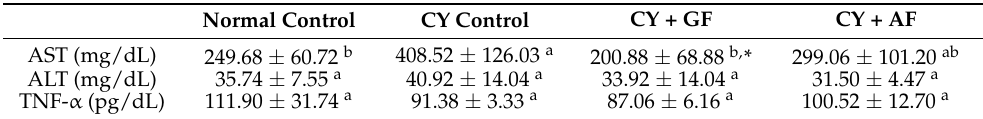
Table 4. Plasma cytokine (TNF- α ) and AST, ALT profile in male BALB/c mice after 10 day on the experimental immunology.